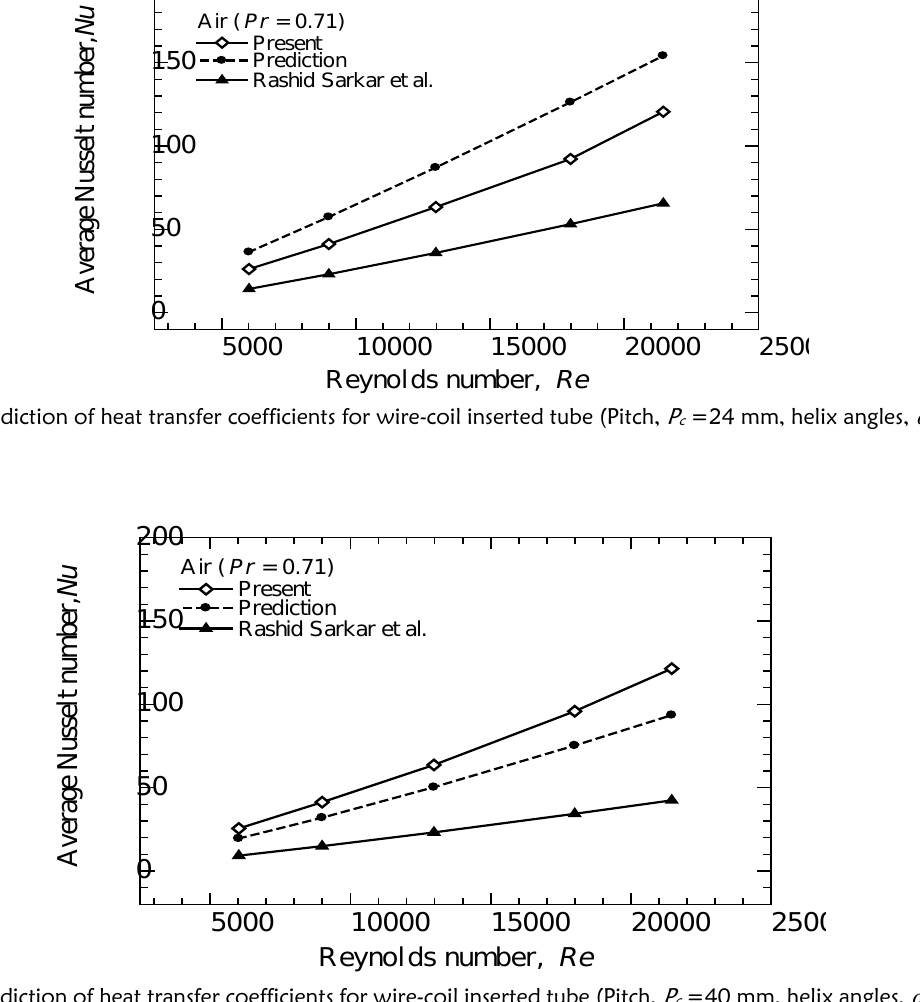
Figure 15: Prediction of heat transfer coefficients for wire-coil inserted tube (Pitch, P c =40 mm, helix angles, α = 35 0